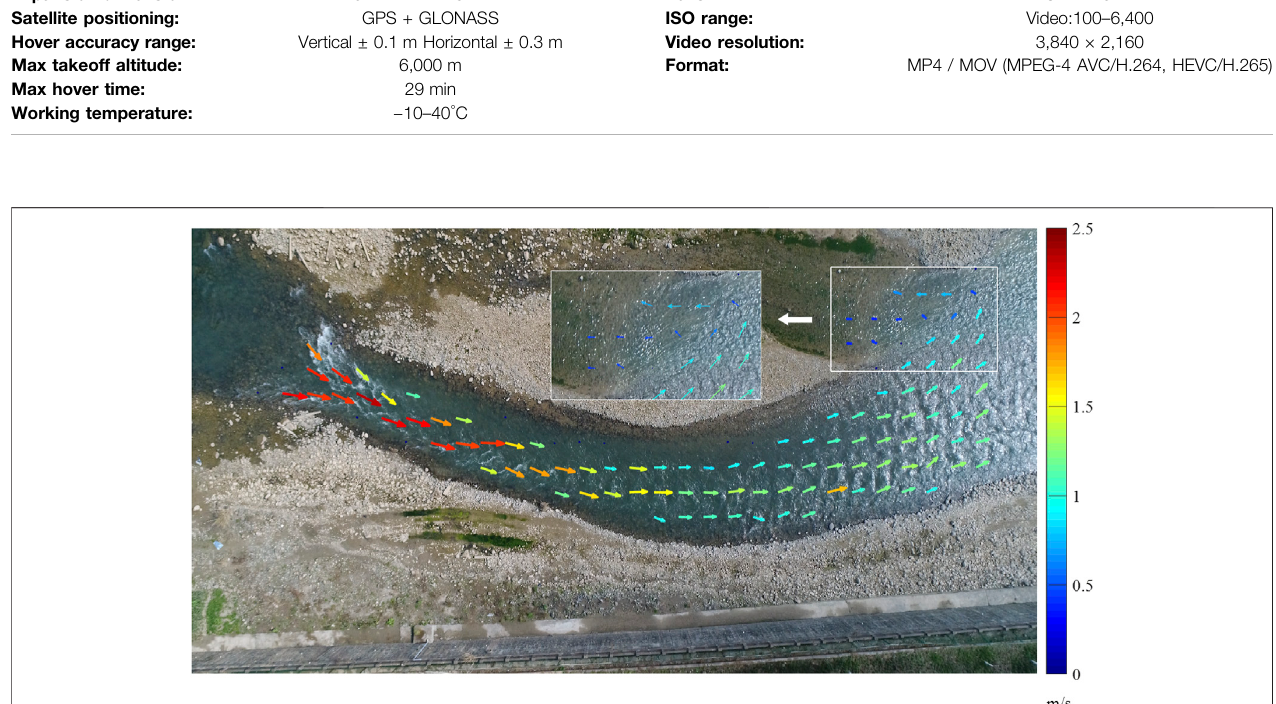
FIGURE 7 | Flow fi eld of Xiasi river surface from the UAV video using 2D STIV. The color and length of the velocity arrows. The grid spacing is 2 m.